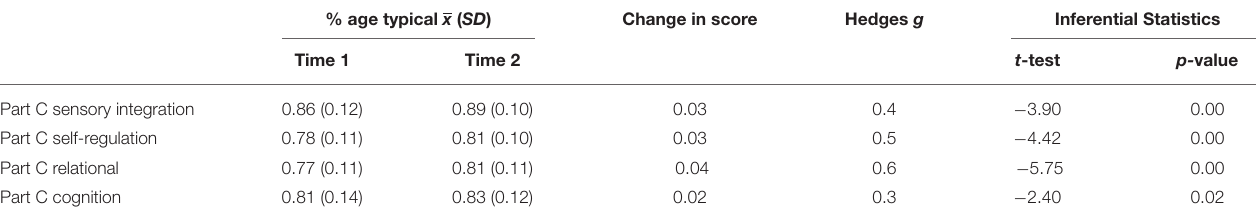
TABLE 9 | Change over time as measured by the NMT current functional domains.